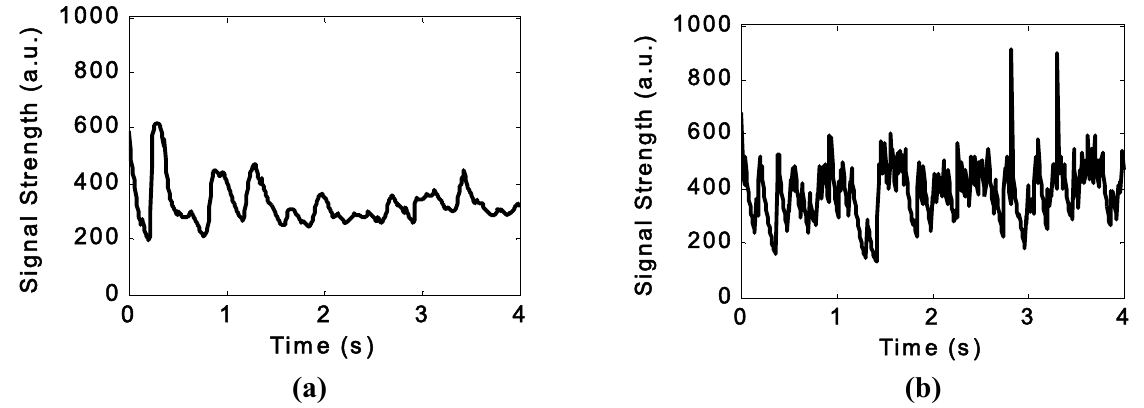
Figure 7. The vibrations detected by the piezoelectric transducers (a) as the pipe is being lowered into the trench and (b) as the response of the buried pipe to a revving car parked at the ground surface.